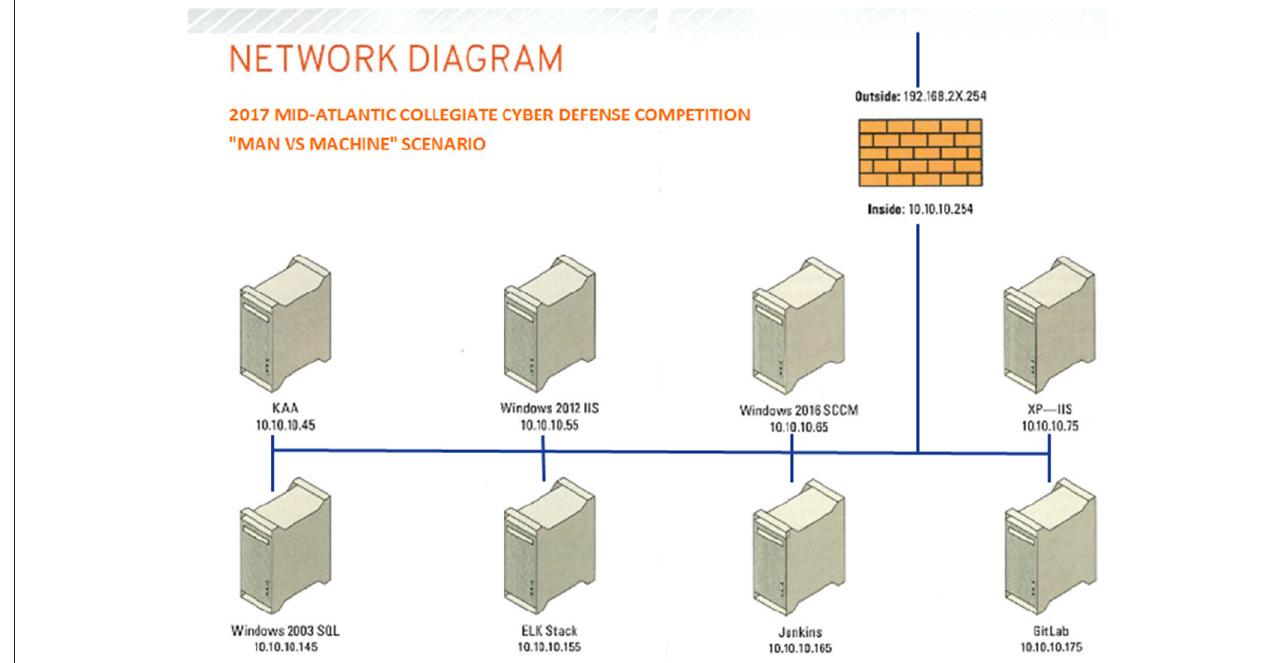
FIGURE 3 | The network diagram of the We-B-Smart